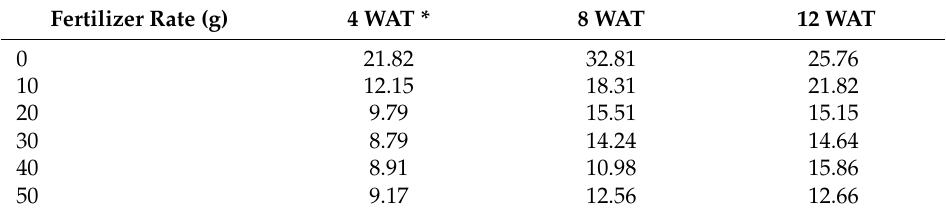
Table 5. Leaf total C:N ratio (mol:mol) at di ff erent fertilizer rates at three sampling times 4, 8, and 12 WAT in Justicia brandegeana . Values are from combining five mature leaves and no petioles from five di ff erent pots per treatment for a single composite sample ( n = 1).